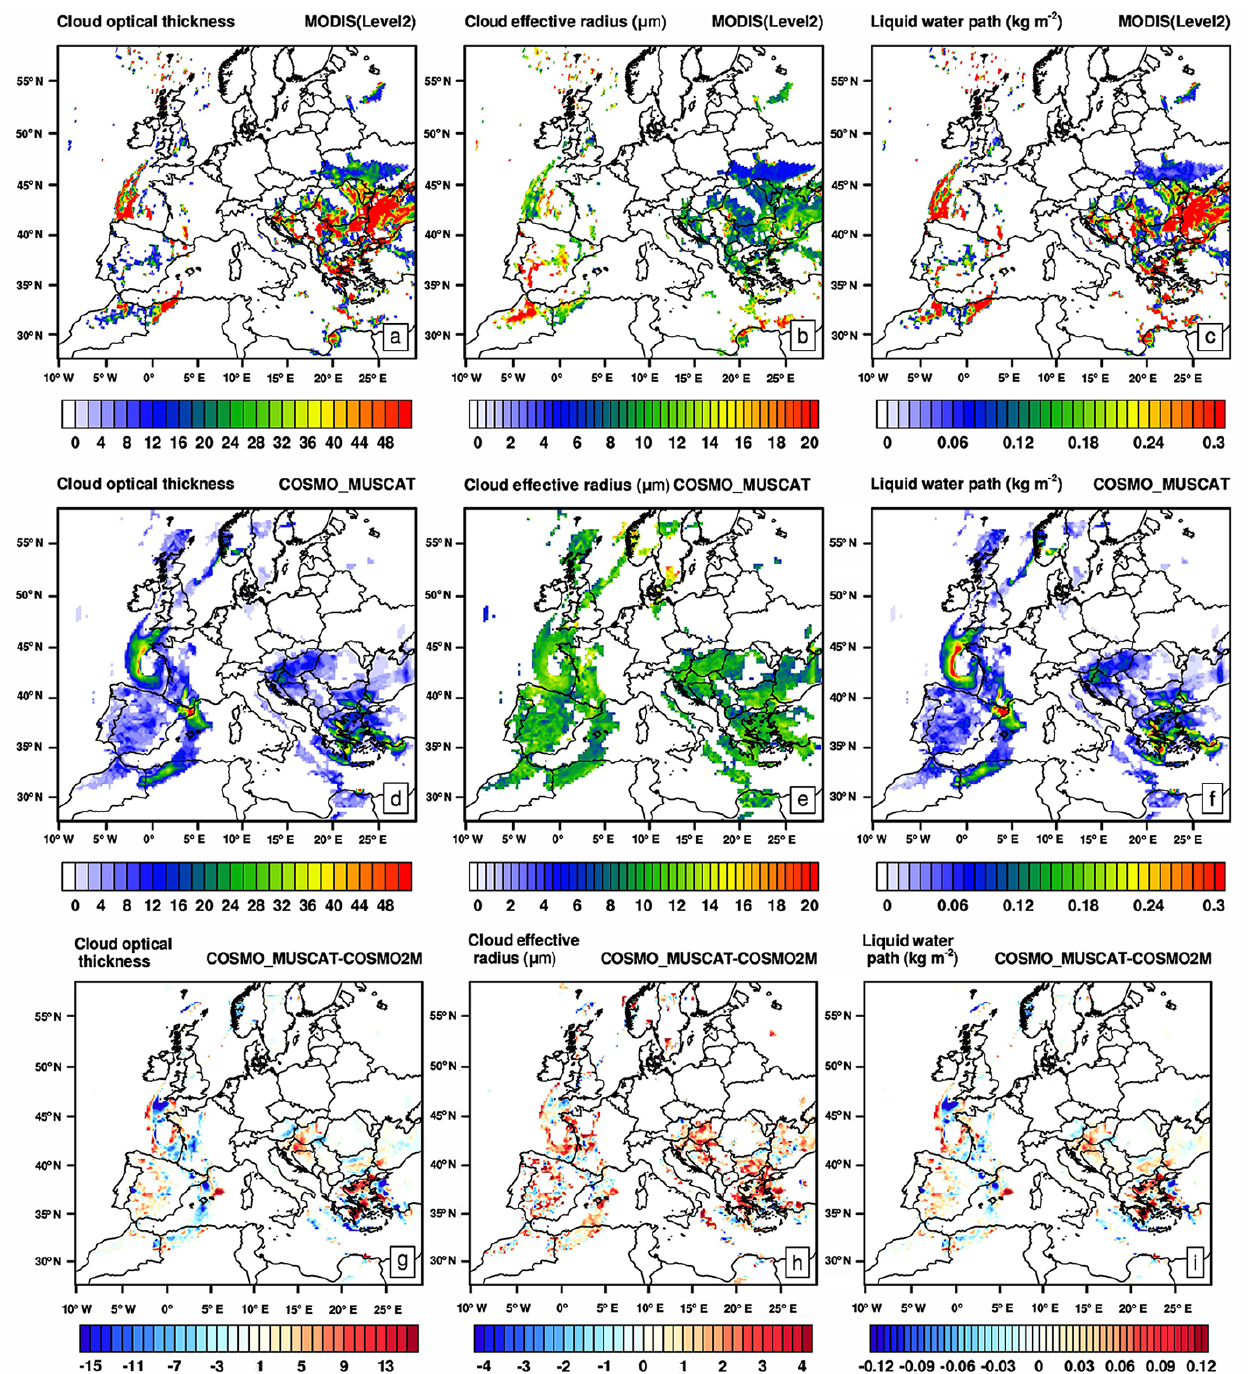
Figure 4. MODIS level-2 (a) cloud optical depth, (b) cloud effective radius, (c) COSMO-MUSCAT-derived cloud water path (averaged between 08:00 and 14:00UTC – approximate MODIS Terra overpass time over the domain), (d) cloud optical depth, (e) cloud effective radius, (f) cloud water path, and the differences between COSMO-MUSCAT and COSMO2M simulations (g, h, i) for 17 February